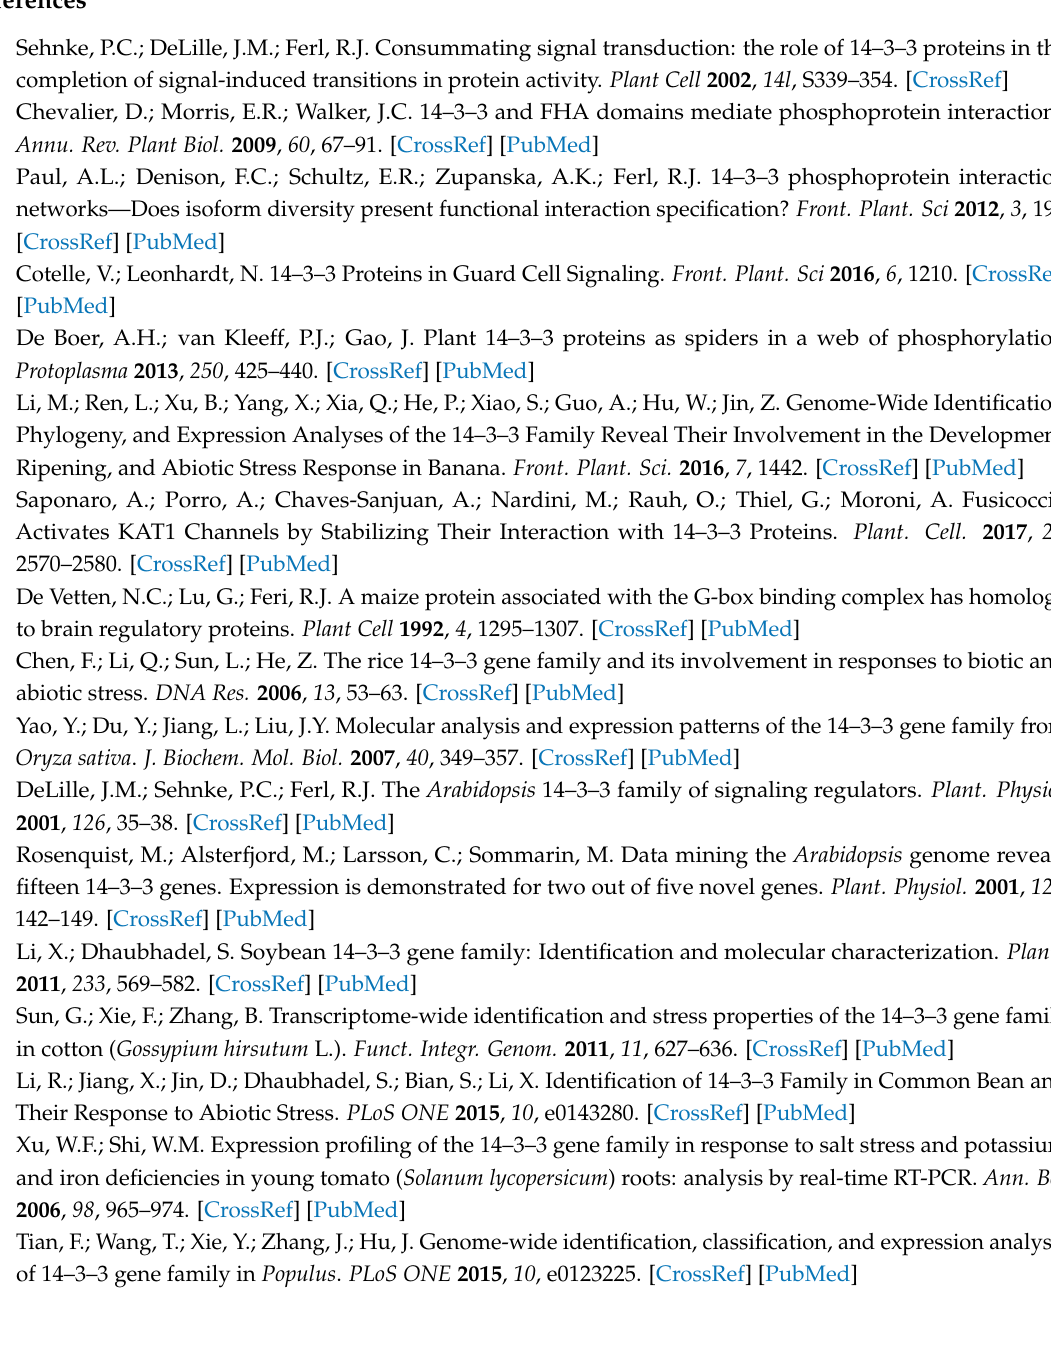
in Arabidopsis . Table S6: The homologous genes in cassava from the interaction network. Table S7. The protein interaction relationship in the GRF-mediated interaction network and the expression of GRFs in